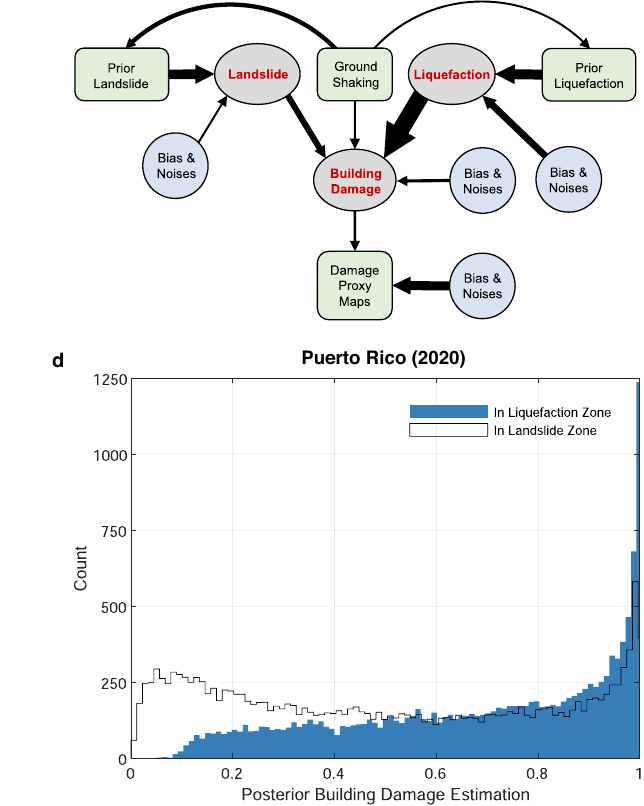
edge. c Estimated building damage probability distribution under the landslide zone (transparent white) and the liquefaction zone (colored blue) for the 2018 Hokkaido,Japanearthquake. d Estimatedbuilding damageprobabilitydistribution under the landslide zone (transparent white) and the liquefaction zone (colored blue) for the 2020 Puerto Rico